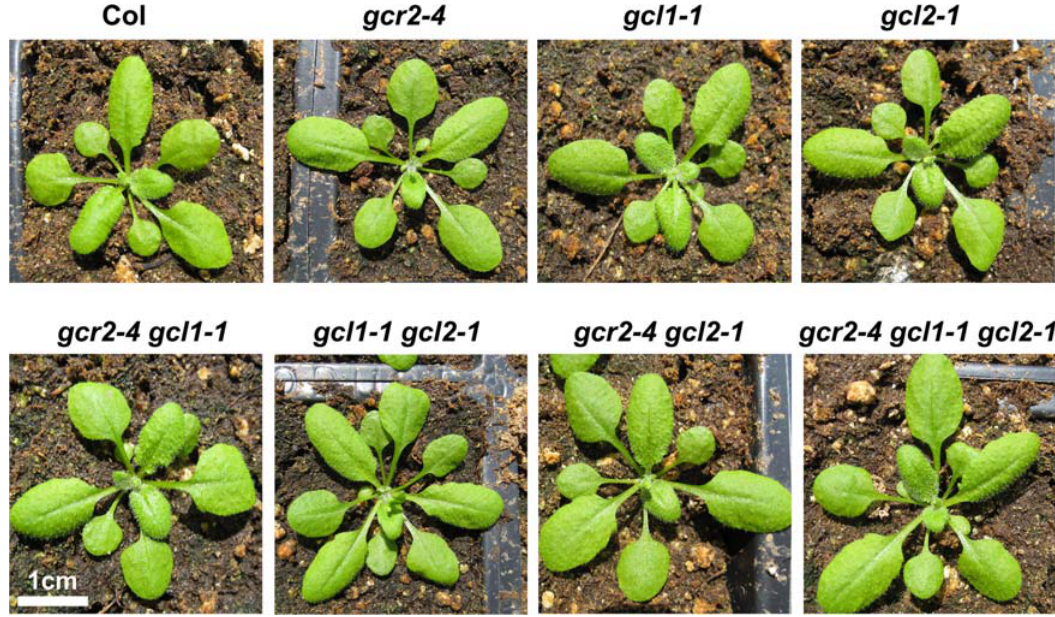
Figure 3. gcr2 , gcl1 and gcl2 single, double and triple mutants. Shown are 21 d-old plants grown under 14/10 hr photoperiod.